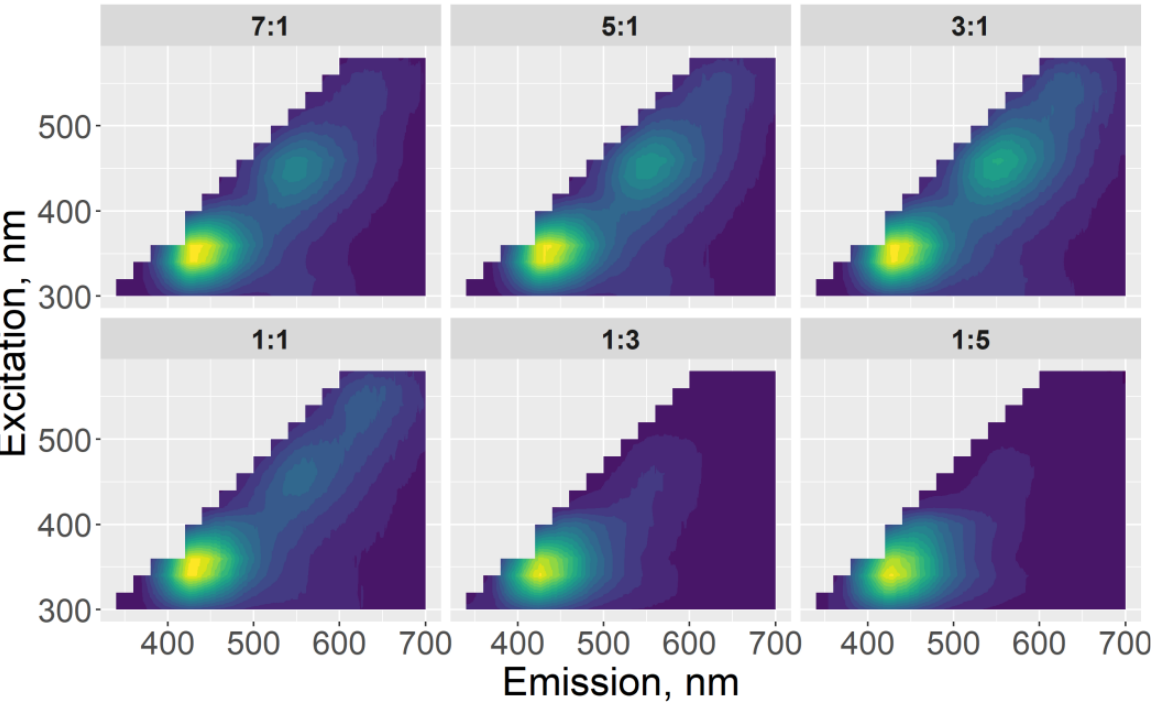
Figure 8. Maps of emission spectra of purified samples prepared from urea and citric acid at differ- ent excitation wavelengths. Sample composition (urea/citric acid) is shown in the subplot captions.